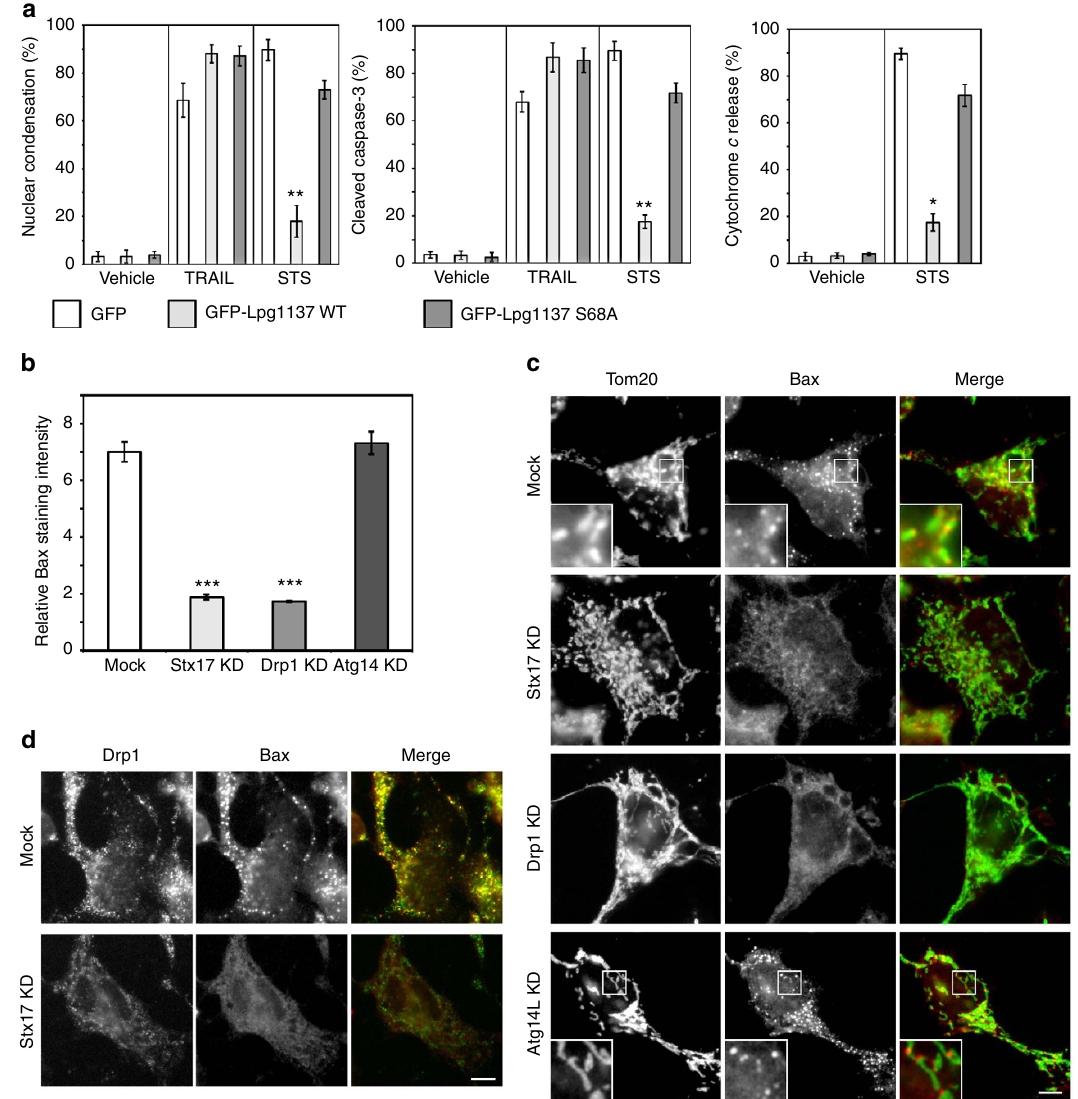
Figure 8 | Loss of Stx17 suppresses STS-induced apoptosis. ( a ) HeLa-Fc g RII cells were transfected with one of the indicated plasmids. At 24h after transfection, cells were mock-treated (Vehicle), or treated with 500ngml (cid:3) 1 TRAIL or 1 m M STS for 4h and then fixed. Cells exhibiting nuclear condensation (left), cleaved caspase-3 (middle) and cytochrome c release from the mitochondria (right) were counted (100 GFP-expressing cells each). Values are means ± s.d. ( n ¼ 4). * P o 0.01 and ** P o 0.001 as compared with GFP-Lpg1137 S68A. ( b ) HeLa-Fc g RII cells with mock treatment or depleted (KD) of Stx17, Drp1 or Atg14L were treated with 1 m M STS for 4h, fixed and then stained with an antibody against Bax (Supplementary Fig. 6). Notably, translocation of Bax to mitochondria increased the staining intensity in cells (Supplementary Fig. 6). One hundred cells were analysed in each experiment. The ratio of the Bax staining intensity between cells after and before STS treatment is plotted. Values are means ± s.d. ( n ¼ 4). *** P o 0.0001 as compared with Mock. ( c , d ) HeLa-Fc g RII cells were treated as described in b except for 2.5-h STS treatment to observe an early stage of apoptosis. Cells were fixed and double stained with the indicated antibodies. Scale bar, 5 m m. Insets in c are magnifications of boxed which the deletion allele had replaced the wild-type allele on the chromosome, and loss of Lpg1137 was confirmed by IB using an antiserum against Lpg1137. Plasmid pcDNA-DEST-53 (Thermo Fisher Scientific) was used for the construction of all GFP fusion effectors encoded by the genes in island 2. Substitution of Ser-68 or Ser-134 was performed by inverse PCR. All FLAG-based Stx17 constructs were constructed as described previously 15 . 3 (cid:2) -FLAG-Atg14L and 3 (cid:2) -FLAG-DFCP1 (template for the FLAG-DFCP1 construct) were generous gifts from Dr Noboru Mizushima (University of Tokyo). Transfection was carried out using Lipofectamine 2000 (Thermo Fisher Scientific) according to the manufacturer’s protocol. Cell culture and transfection . HeLa cells were obtained from the RIKEN Bior- esource Center (RCB0007) and found to be free from mycoplasma contamination. Chemicals and antibodies . Chemicals were obtained from the following sources: HEK293 cells stably expressing Fc g RII (HEK293-Fc g RII cell) were maintained as described previously 11 . HeLa cells stably expressing Fc g RII (HeLa-Fc g RII cell) were Hoechst 33342 (Thermo Fisher Scientific), PMSF (Wako chemicals), MG132 (Calbiochem), TRAIL (Merck Millipore), STS (Wako chemicals) and Percoll established as described previously 11 , and grown in a -MEM supplemented with